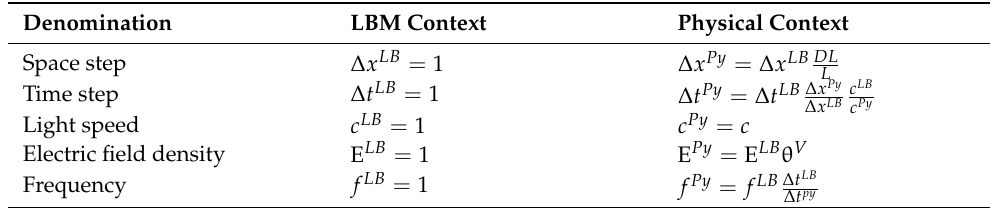
Table 1. Conversion between the LBM and physical